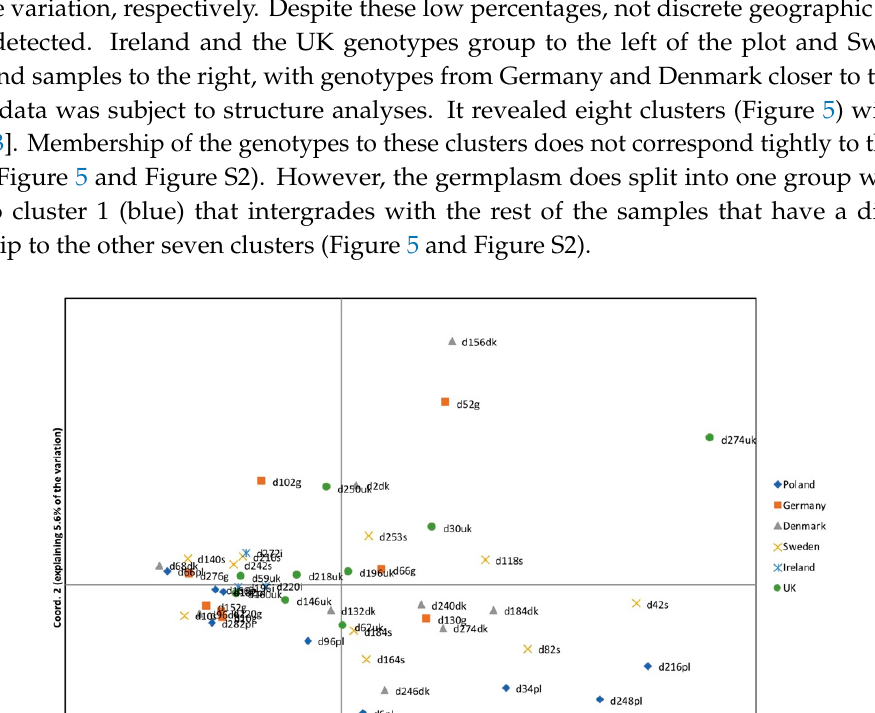
Figure 5. Structure of Dactylis glomerata genotypes estimated using structure analysis of plastome SNPs. Each plant is shown as a vertical bar and SNP variation is partitioned into coloured segments that show the individual’s estimated membership fractions in each of the K = 8 clusters, determined